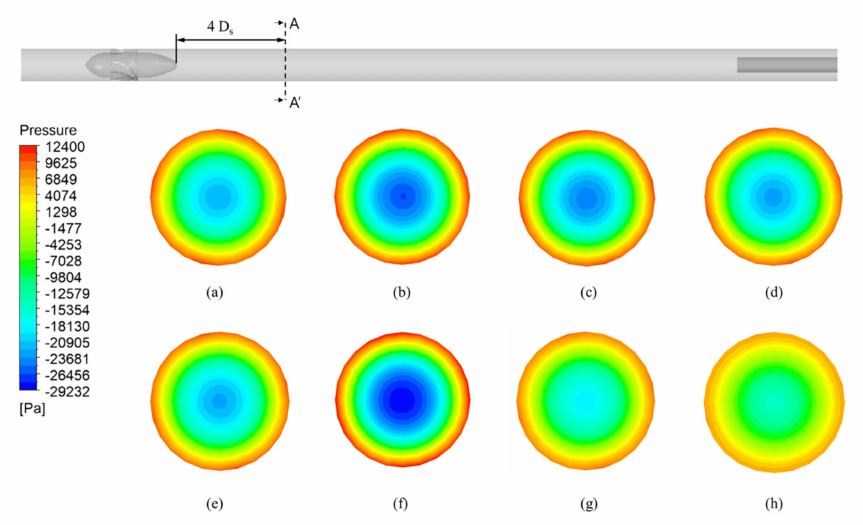
Figure 10. Distribution of pressure at 4 D s (A-A’) downstream of the ISE: ( a ) case 1, ( b ) case 2,